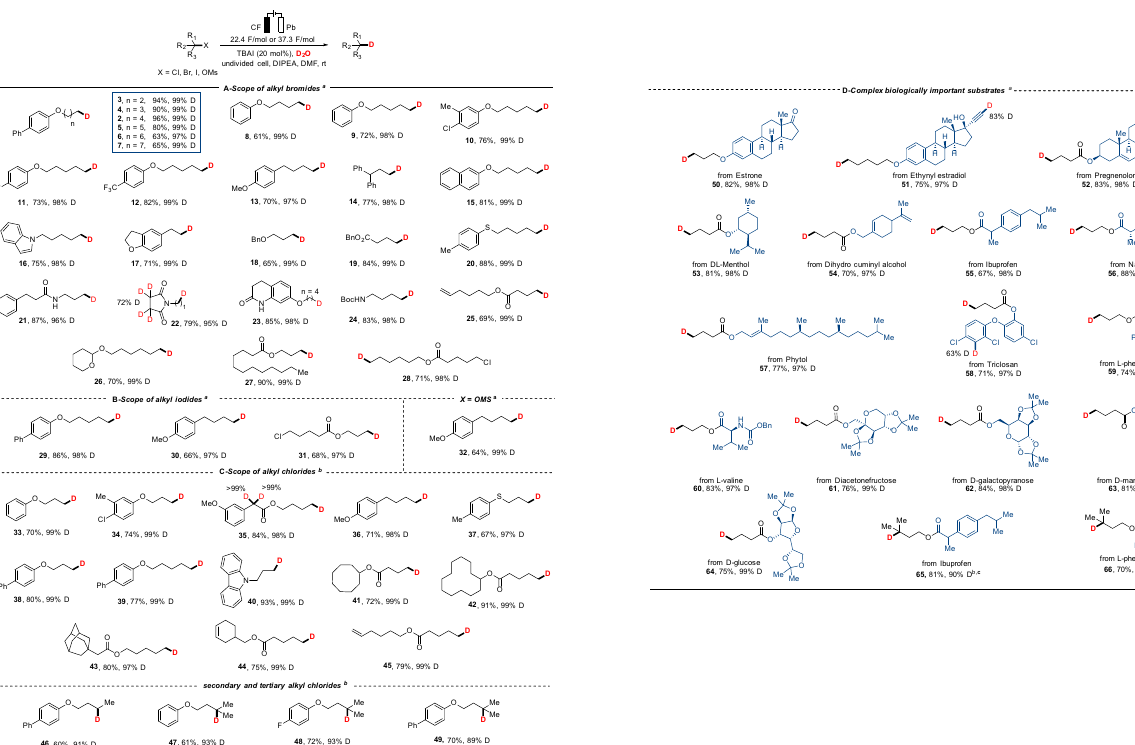
Fig. 2 Electrochemically driven dehalogenative deuteration of unactivated alkyl halides. A Scope of alkyl bromides, B scope of alkyl iodides, C scope of alkylchlorides, and D complex biologically important substrates. a Reaction conditions: bromide, iodide or pseudo-halides (0.5mmol), D 2 O (25mmol), TBAI (20mol %), DIPEA (1.5mmol), DMF (5.0mL) under 30mA constant current in an undivided cell at room temperature for 10h with carbon felt as anode and lead plate as cathode. Isolated yield of product. Deuterium incorporation determined by 1 H NMR. b Alkyl chlorides (0.5mmol) was conducted under 50mA constant current with graphite felt as anode. c Deuterium incorporation determined by